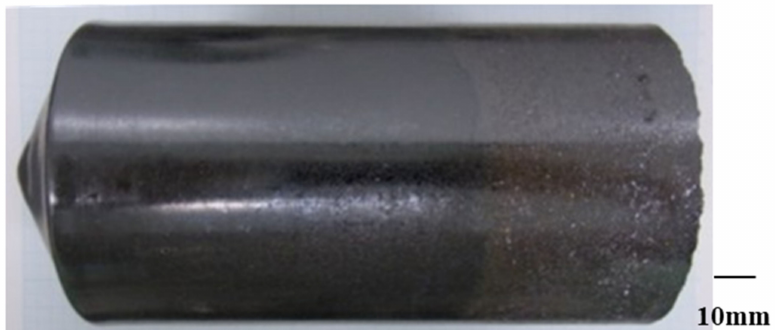
Figure 2. Mn:PIN-PMN-PT single crystal boule grown by continuous-feeding Bridgman